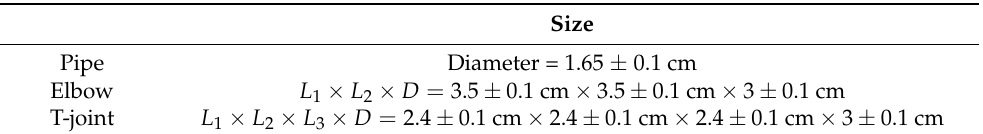
Figure 1. Two Seaperch UUVs. Table 1. Size of pipe, elbow and T-joint of Seaperch UUV.